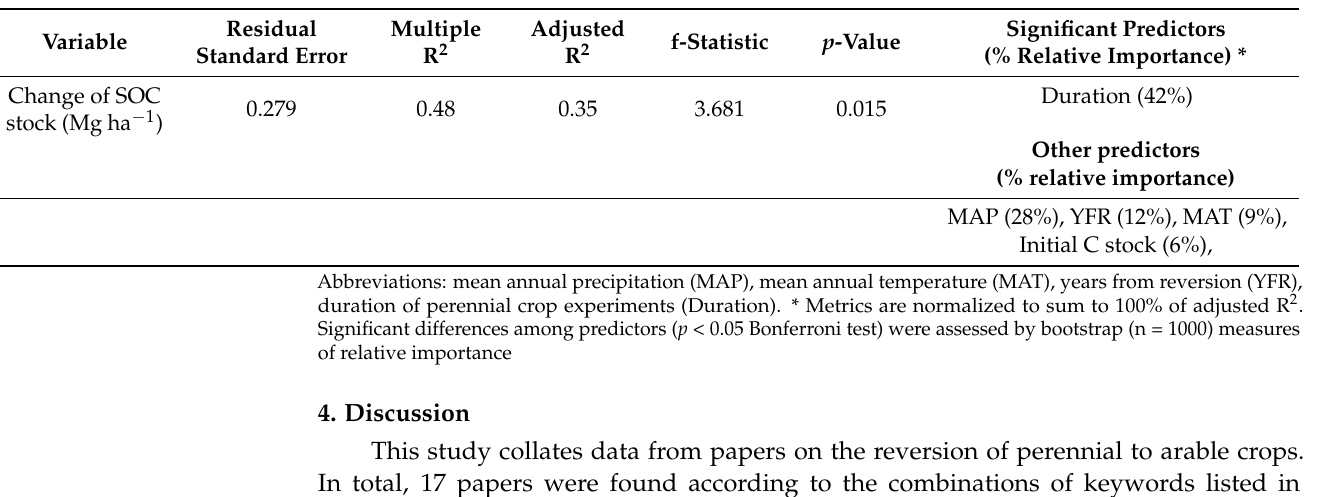
Table 4. Summary statistics of the regression